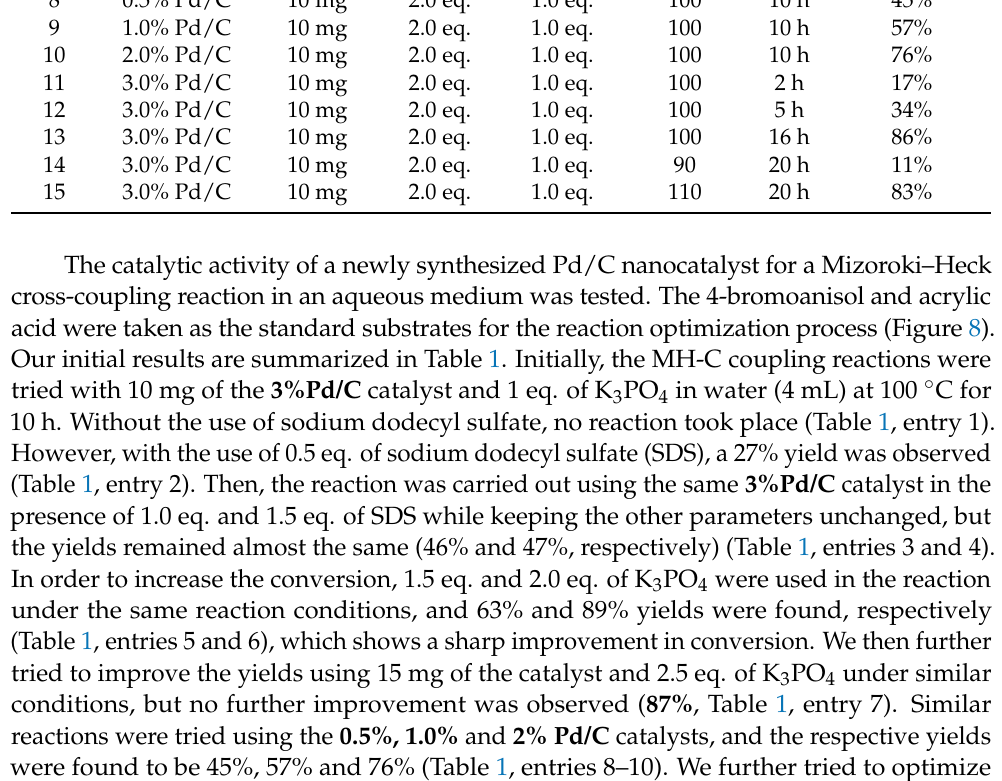
(1.0–2.5 mmol), SDS (0.5–1.5 mmol) and water (4 mL) were charged with a small magnetic